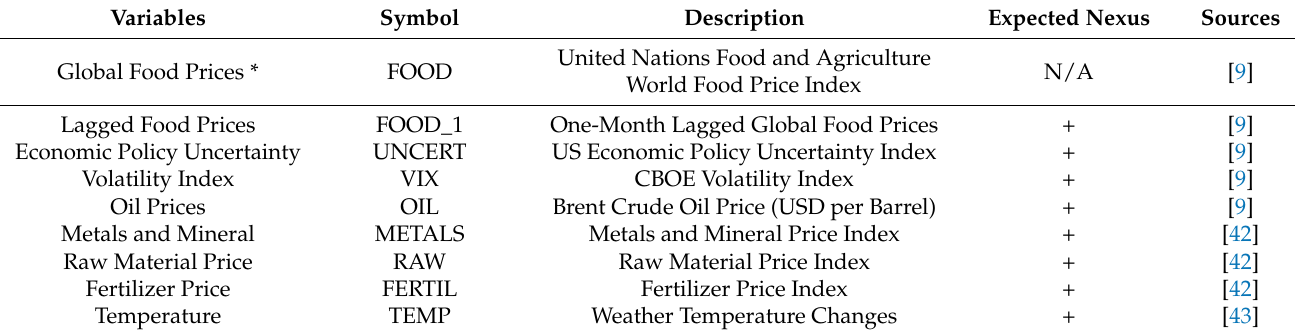
Table 1. The definitions of the